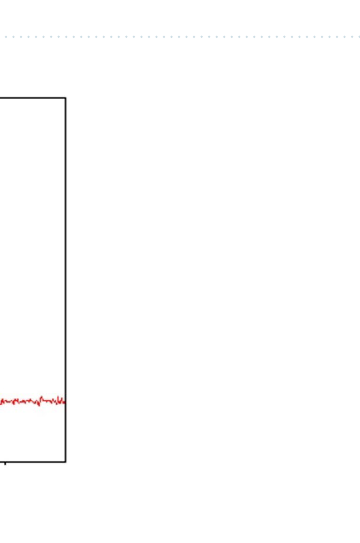
Figure 5. N 2 adsorption–desorption isotherms of the Iron oxide@PMO-ICS-PrSO 3 H mesoporous materials ( 1 ).